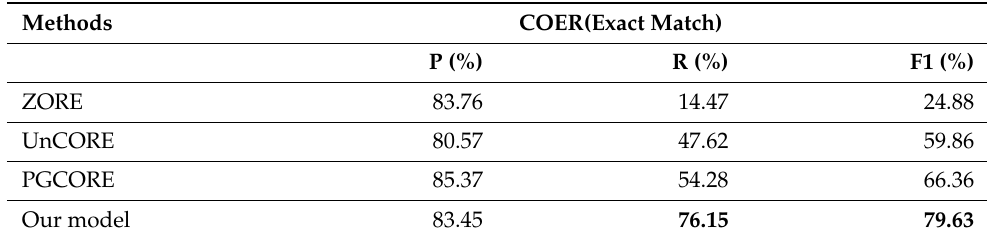
Table 3. The results of each method on COER. Some experimental results are directly quoted from previous comparative experiments.